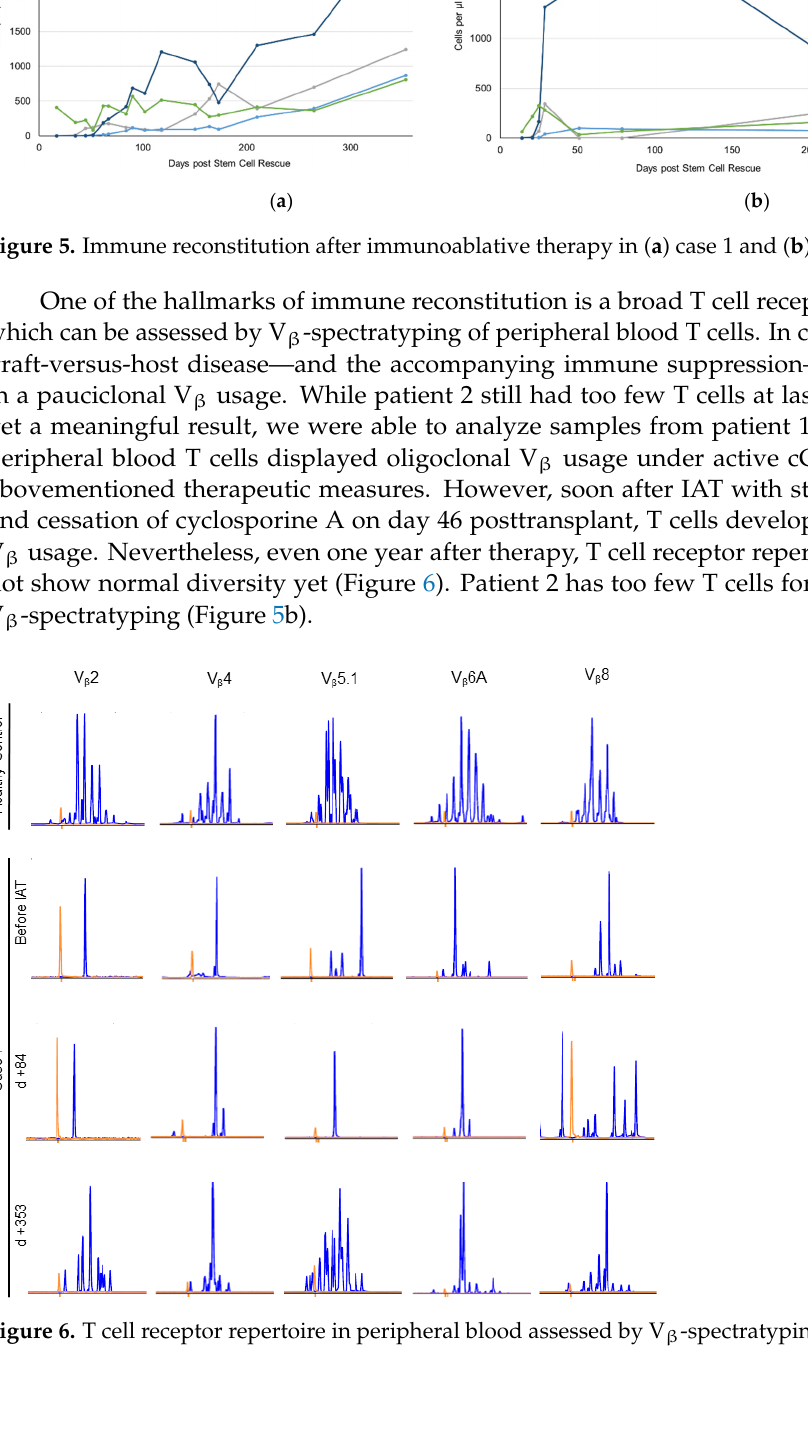
Figure 4. Regression of cGvHD in patient 2. Arrows indicate residual areas of fibrotic thickening of the skin, which had covered both hands and have resolved completely.